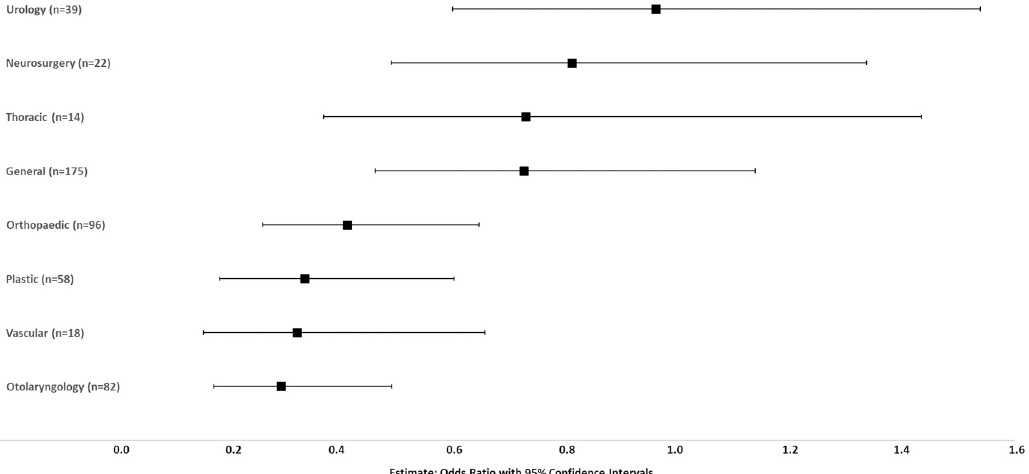
Fig 5. Prediction modeling of the impact of specialty on likelihood of women academic surgeons attaining highest levels of promotion (Professor, Professor Emeritus/Honorary Associate Professor/Distinguished Professor). Controlled for university and higher degrees. Odds ratio with 95% confidence interval graphed for each specialty compared to the reference specialty (Cardiac Surgery, 0.22, highest proportion of women at the highest levels of promotion).